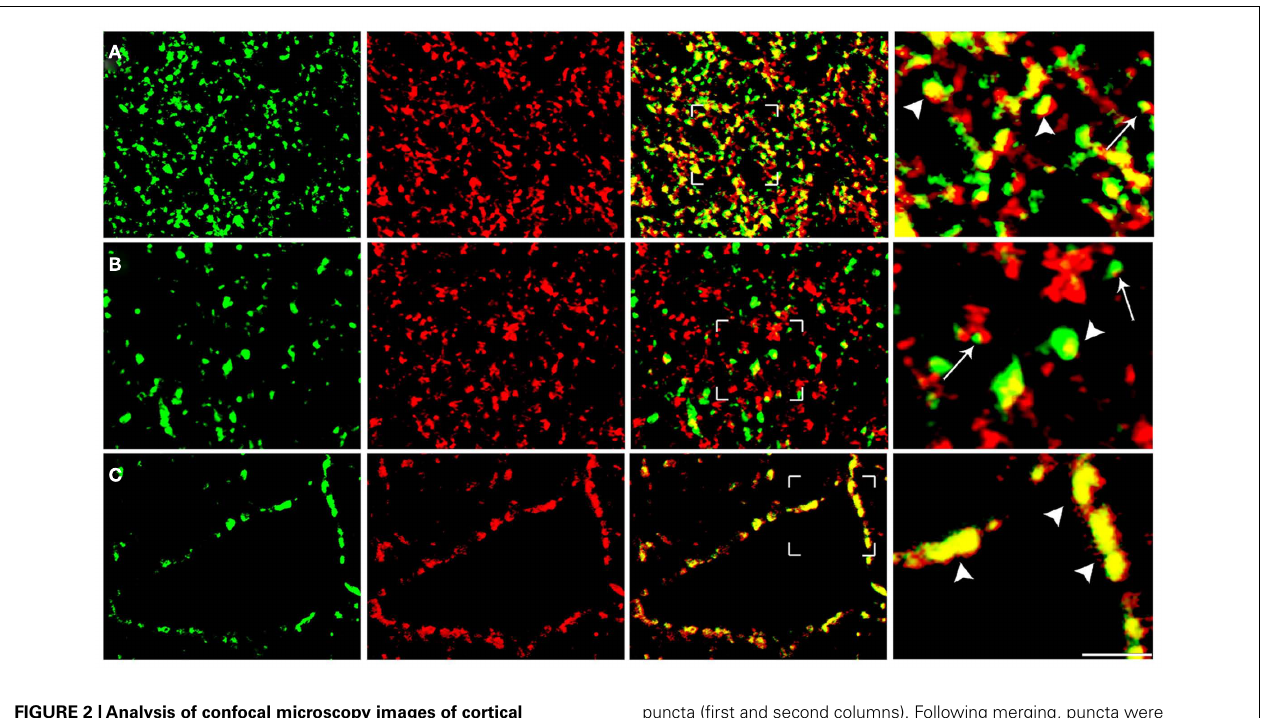
FIGURE 2 |Analysis of confocal microscopy images of cortical sections. The figure shows examples fromVGLUT1/SYT1 [row (A) ], VGLUT2/Rab3a [row (B) ], andVGAT/SV2A series [row (C) ].To minimize the fusion of puncta, the contrast of each image was manually adjusted within the maximum range of levels for each color channel, which was examined separately to identify and count manually immunopositive